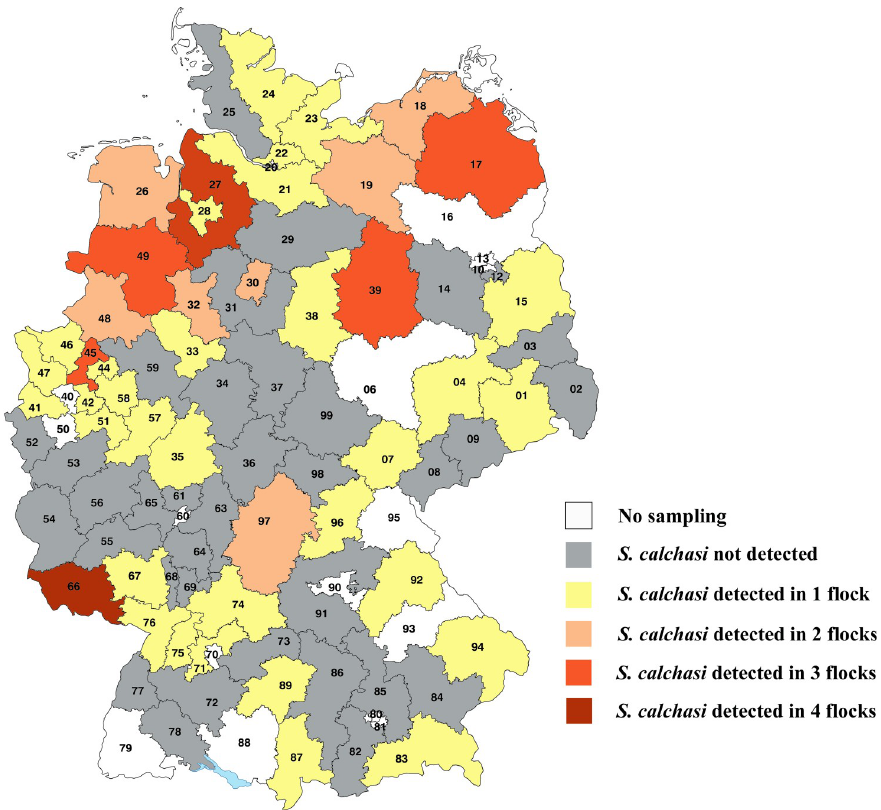
Fig 1. Detection of S . calchasi DNA in racing pigeon flocks by division into districts. Map of Germany fielded by postal codes.